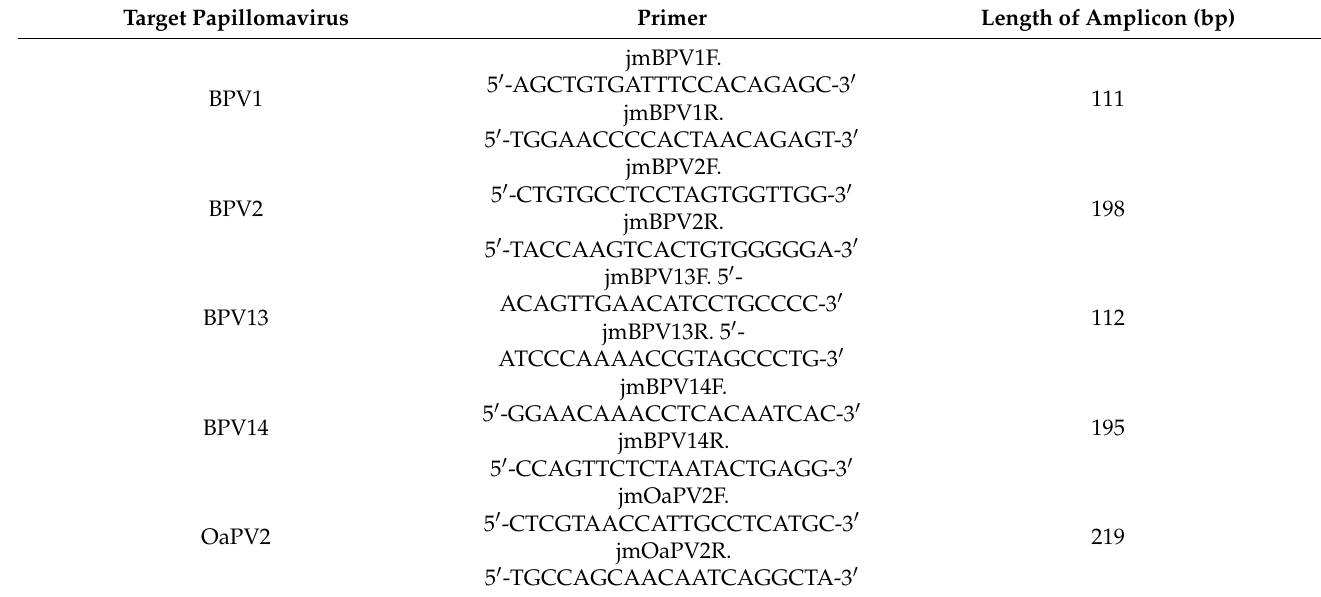
Table 1. The primer sequences used to amplify the five sarcoid-associated deltapapillomavirus types in this study. BPV is bovine papillomavirus, OaPV is Ovis aries papillomavirus. Target Papillomavirus